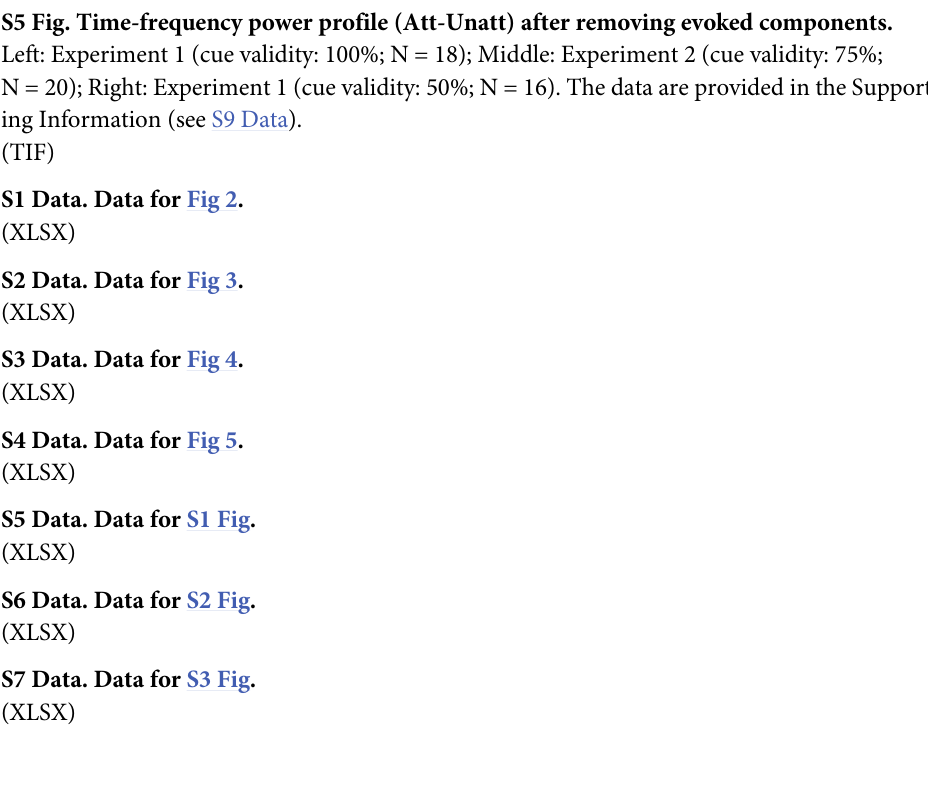
200 ms alpha-band (dotted white box) inhibition (bottom), for discs presented in the left visual field. (D) Same as C but for discs presented in the right visual field. Note the similar initial alpha-band inhibition and similar spatial distribution to those in Fig 2C & 2D. The data are provided in the Supporting Information (see S6 Data). S3 Fig. Control analysis for alpha echoes. (A) Alpha echoes in Experiment 1. Grand average time-frequency power profile for attended (att) TRF (left) and unattended (unatt) TRF (right), as a function of latency (0.3–0.8 s) and frequency (0–30 Hz). (B) Alpha-echo power (averaged from 0.3–0.6 s, dotted black rectangle) for att (black bar) and unatt (white bar) TRFs. (C) Same as (A) but for Experiment 2. (D) Same as (B) but for Experiment 2. Note the larger overall alpha echoes in both experiments, similar to the results of VanRullen and MacDonald (2012). The data are provided in the Supporting Information (see S7 Data). S4 Fig. Control experiment for Experiment 3. Left: Subjects fixated on a central point and covertly attended to two discs presented in the upper and lower visual field, within the same visual hemifield. Subjects were instructed to pay attention to the two discs simultaneously and were informed that the target was equally likely to appear within both and that the initial cue would not predict the target location. After an uninformative red circle cue (cue validity: 50%) appeared in one of the two discs, the luminance of the two discs was independently and ran- domly modulated for 5 seconds. Right: Grand average (N = 13) time-frequency plots for cued– uncued TRF power difference. Note the same alpha-band alternating pattern, thus arguing against the interpretation of interhemispheric competition for Experiment 3. The data are pro- vided in the Supporting Information (see S8 Data). S5 Fig. Time-frequency power profile (Att-Unatt) after removing evoked components. Left: Experiment 1 (cue validity: 100%; N = 18); Middle: Experiment 2 (cue validity: 75%; N = 20); Right: Experiment 1 (cue validity: 50%; N = 16). The data are provided in the Support- ing Information (see S9 Data). S1 Data. Data for Fig 2. S2 Data. Data for Fig 3. (XLSX) S3 Data. Data for Fig 4. (XLSX) S4 Data. Data for Fig 5. (XLSX) S5 Data. Data for S1 Fig. (XLSX) S6 Data. Data for S2 Fig. (XLSX) S7 Data. Data for S3 Fig.